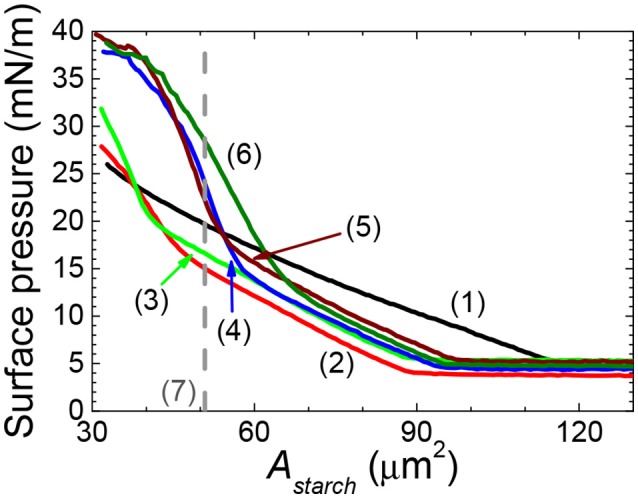
Surface pressure-area per rice starch particle (Astarch) isotherm of films of native and OSA modified rice starch particles spread at an air/water interface. NRS: black solid line (1); 0.6RS: red solid line (2); 1.2RS: green solid line (3); 1.8RS: blue solid line (4); 2.4RS: wine color solid line (5); 3.0RS: olive color solid line (6). Area expected for a hexagonal packed layer of particles with mean starch size is shown by the dashed line (7).